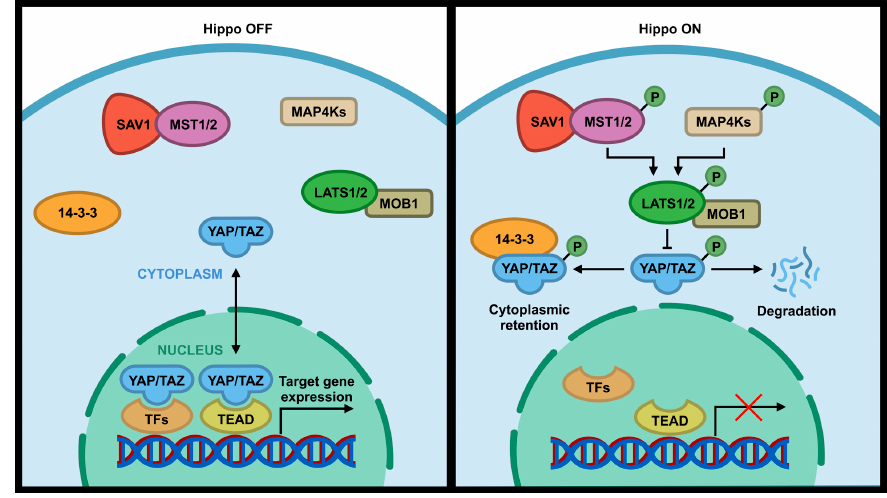
kinases. Activated LATS1 / 2 phosphorylate transcriptional coactivator YAP / TAZ, preventing entry